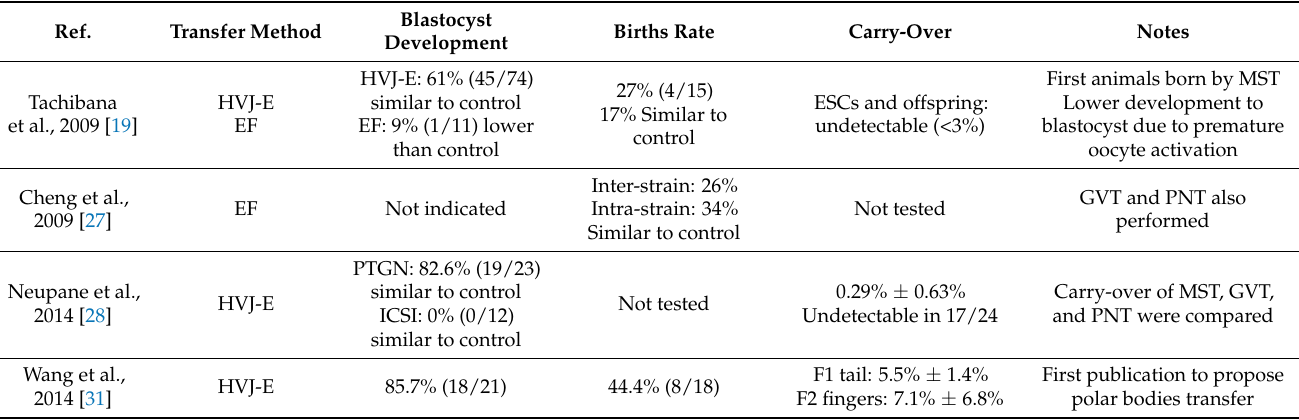
Table 3. Results of MST in animal